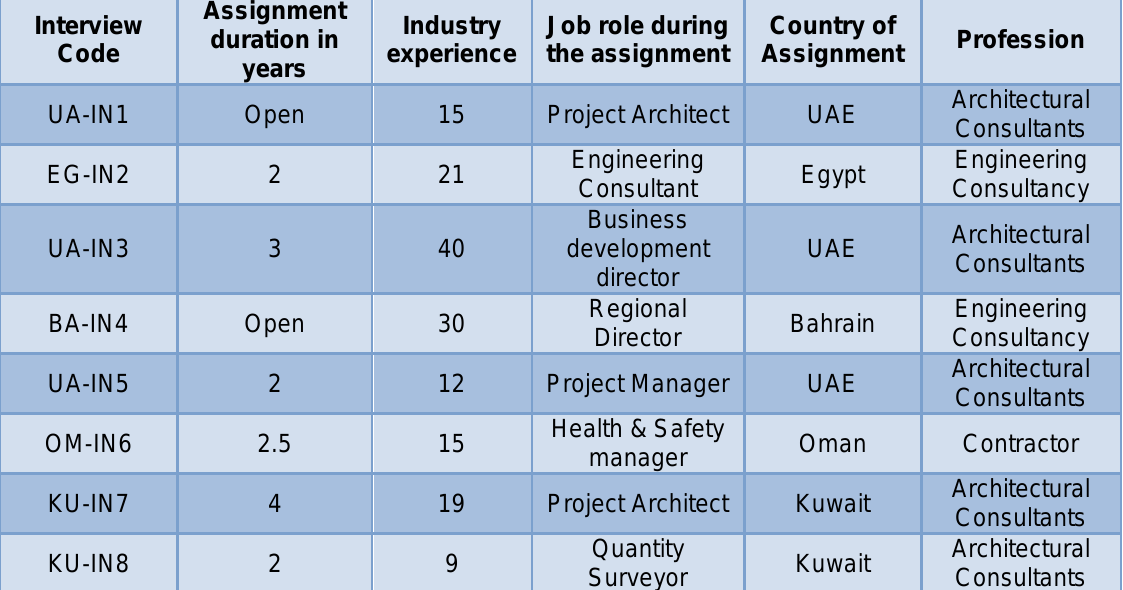
Table 1 Respondents profile for individual